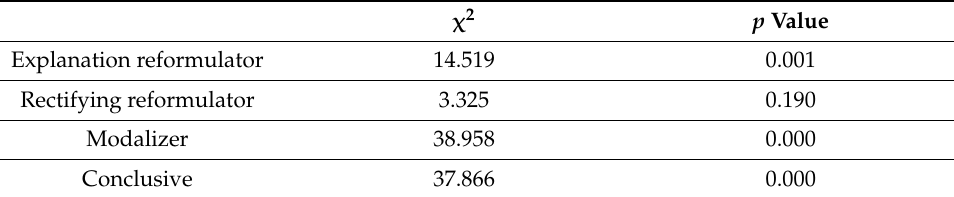
Table 4. Data from the Kruskal–Wallis ANOVA on the functions of vamos and the age variable.